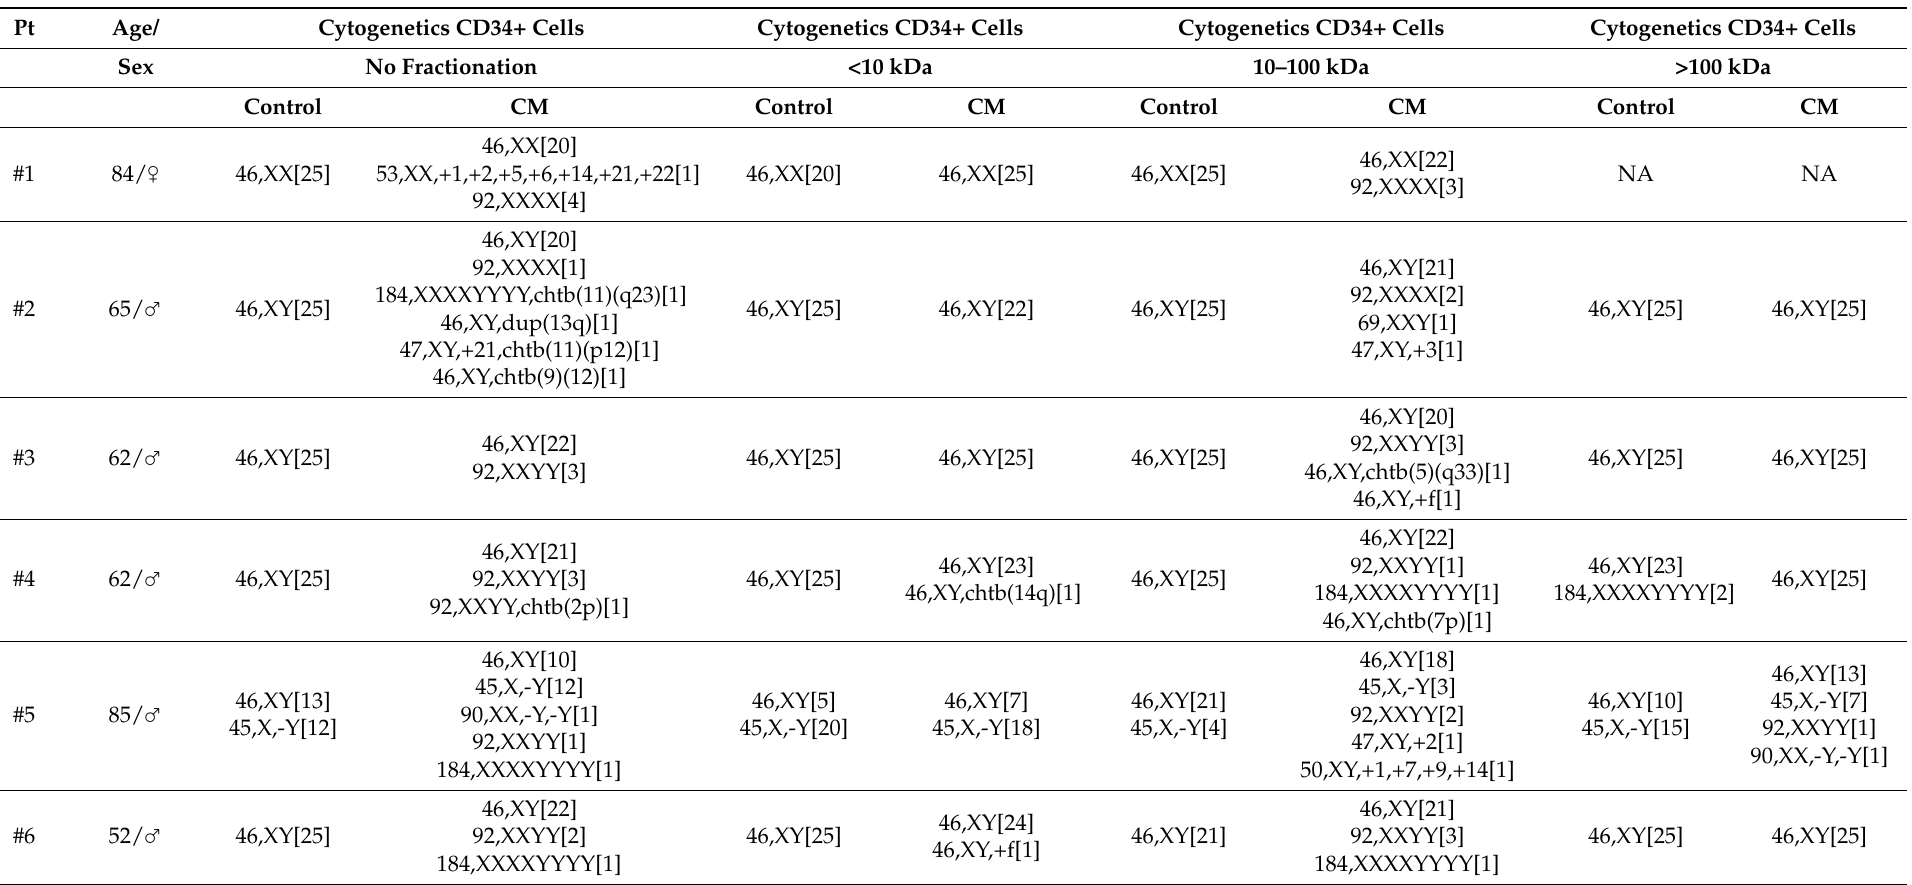
Table 1. Cytogenetics in CD34+ cells grown for 3 days in un-/fractionated medium conditioned by 2 Gy irradiated mesenchymal stromal cells. CM, conditioned medium; NA, not assessed; Pt, patient; [number] = number of